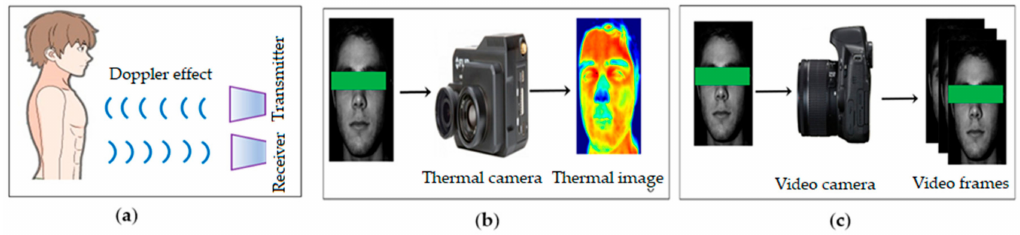
Figure 1. Contactless measuring methods. ( a ) The Doppler e ff ect; ( b ) thermal imaging; ( c ) video camera